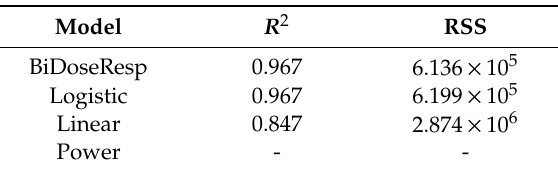
Table 3. The parameters of BiDoseResp